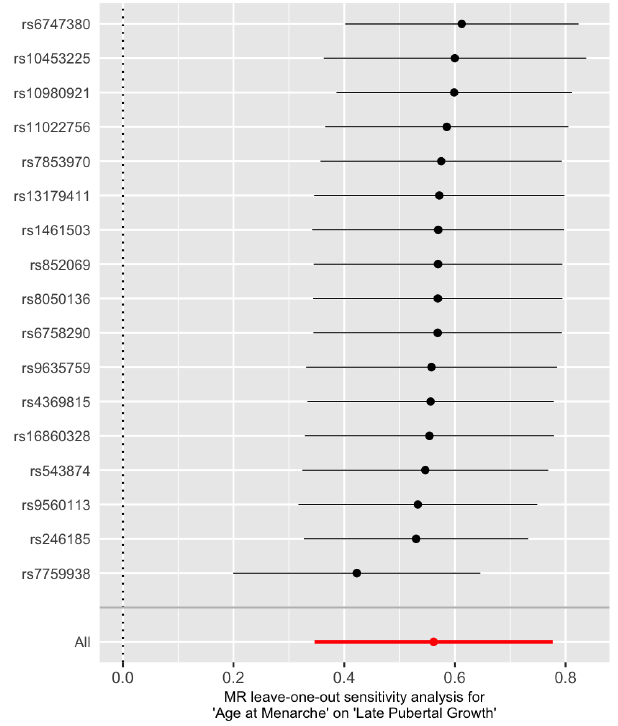
Figure 4. Leave-one-out plot of the IVW estimate for late pubertal growth when a SNP is left out. The red dot represents the IVW estimate using all SNPs.